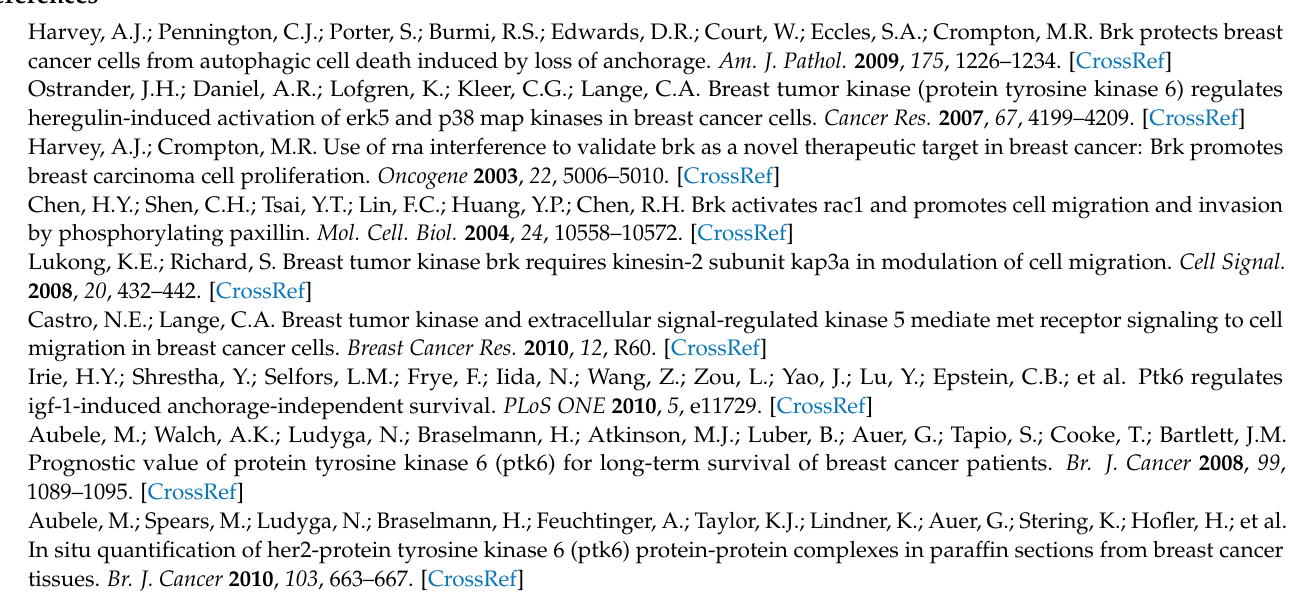
western blotting. Table S1: PTK6 overall survival. Table S2: PTK6 disease free survival. Table S3: ALT-PTK6 overall survival. Table S4: ALT-PTK6 disease free survival. Table S5: ALT-PTK6:PTK6 ratio and overall